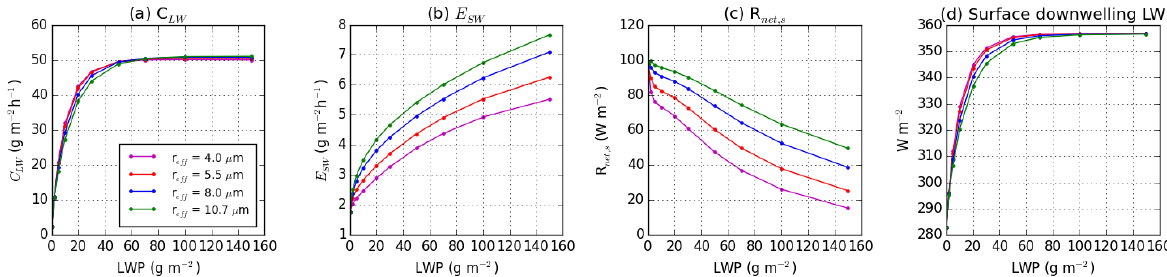
Figure 8. Dependency of C LW (a) , E SW (b) , R net , s (c) (defined in Sect. 2.1), and the downwelling LW flux at the surface (d) on the fog LWP and effective radius. All other input data are fixed to the values of 27 October 2014 at 08:30UTC: the fog is 100m thick with no above clouds and there is a solar zenith angle of 73.9 ◦ .